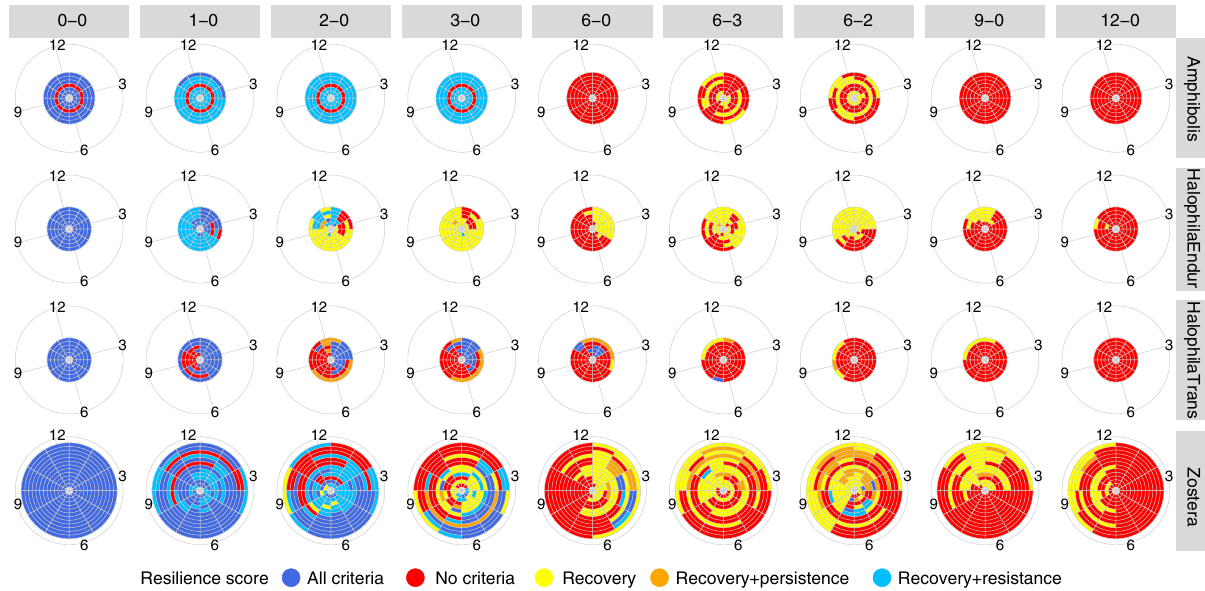
Fig. 3 Ecological windows for seagrasses by life history strategy/genus, and dredging design. Each ring on a pie corresponds to a site, ordered from southernmost to northernmost going from innermost ring to outermost ring. Resistance, recovery and persistence criteria were considered and criteria scores are colour coded. A score that is not red is considered an ecological window. For individual site results, refer to Supplementary Figs. 1 and 2